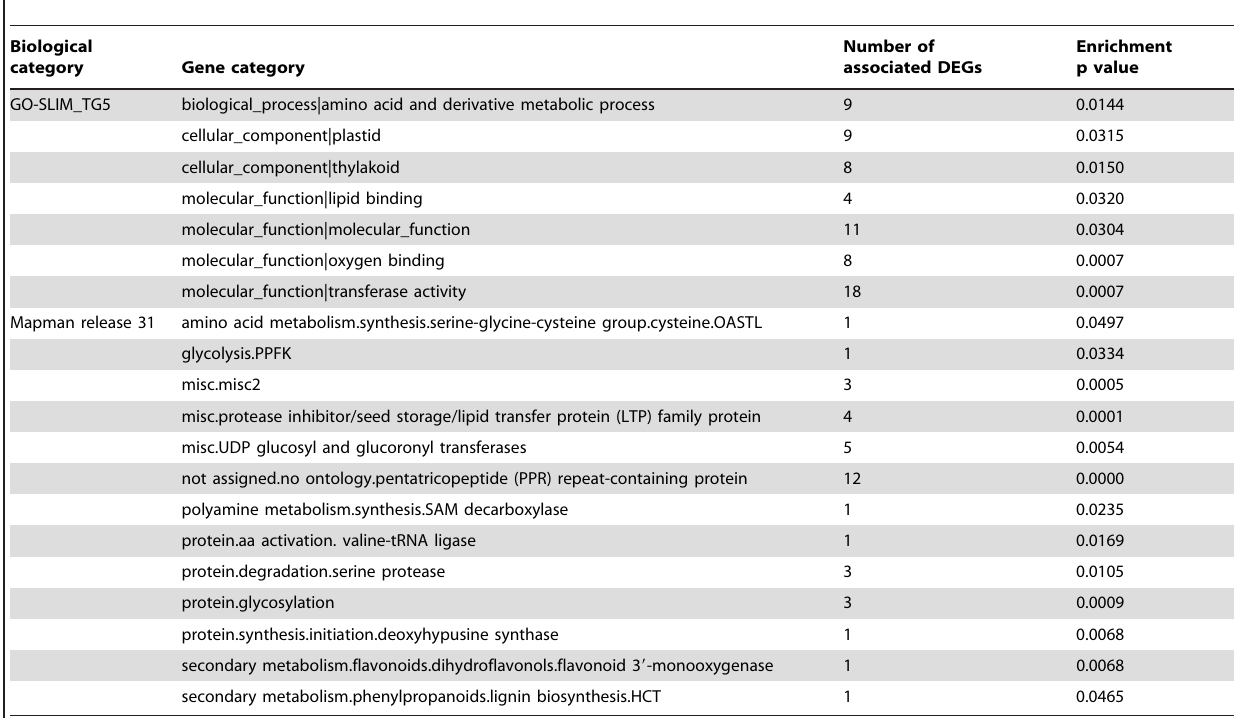
Table 4. Enriched GO-SLIM and Mapman pathways from the differentially expressed genes associated with drought-yield QTL.